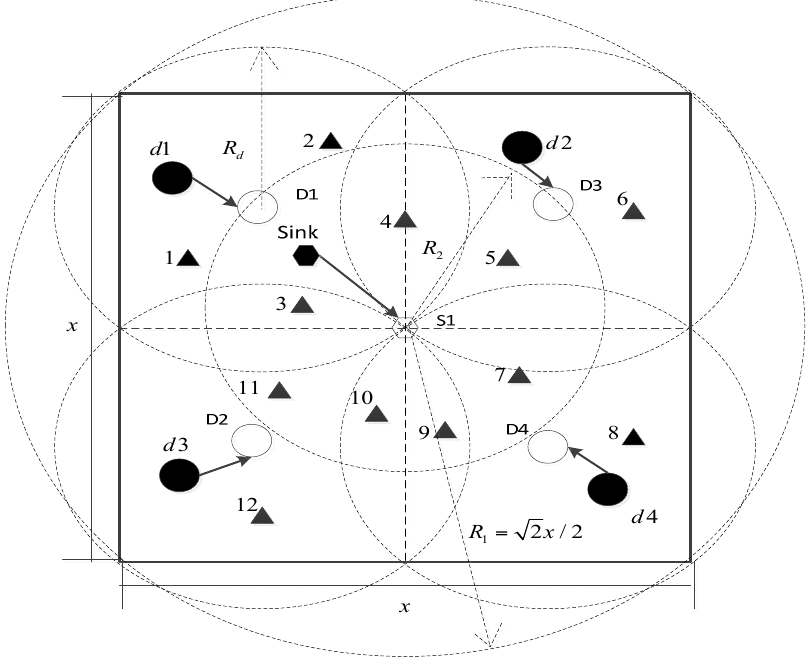
Figure 2. Dispatch model based on dispatch nodes.